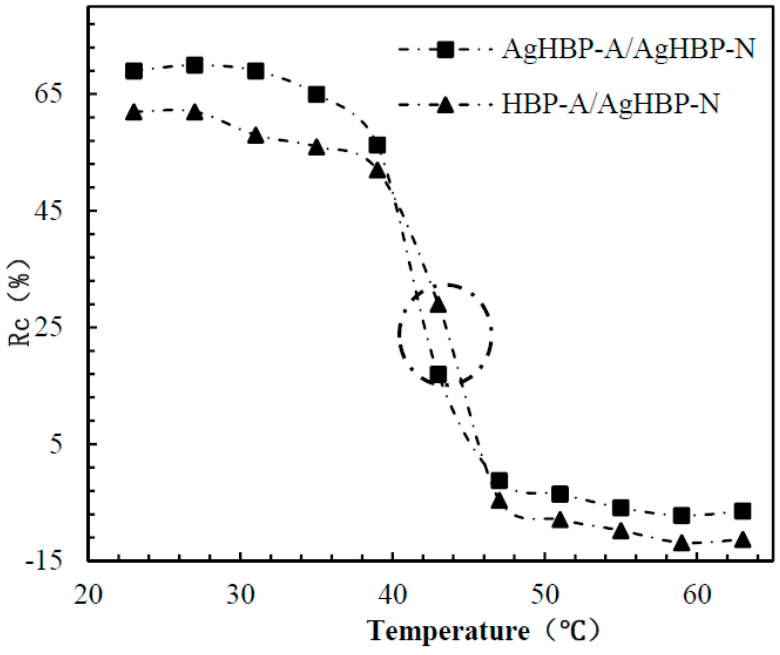
Figure 6. DLS curves of the prepared polymer reactors. (The circle means the LCST of AgHBP-A).